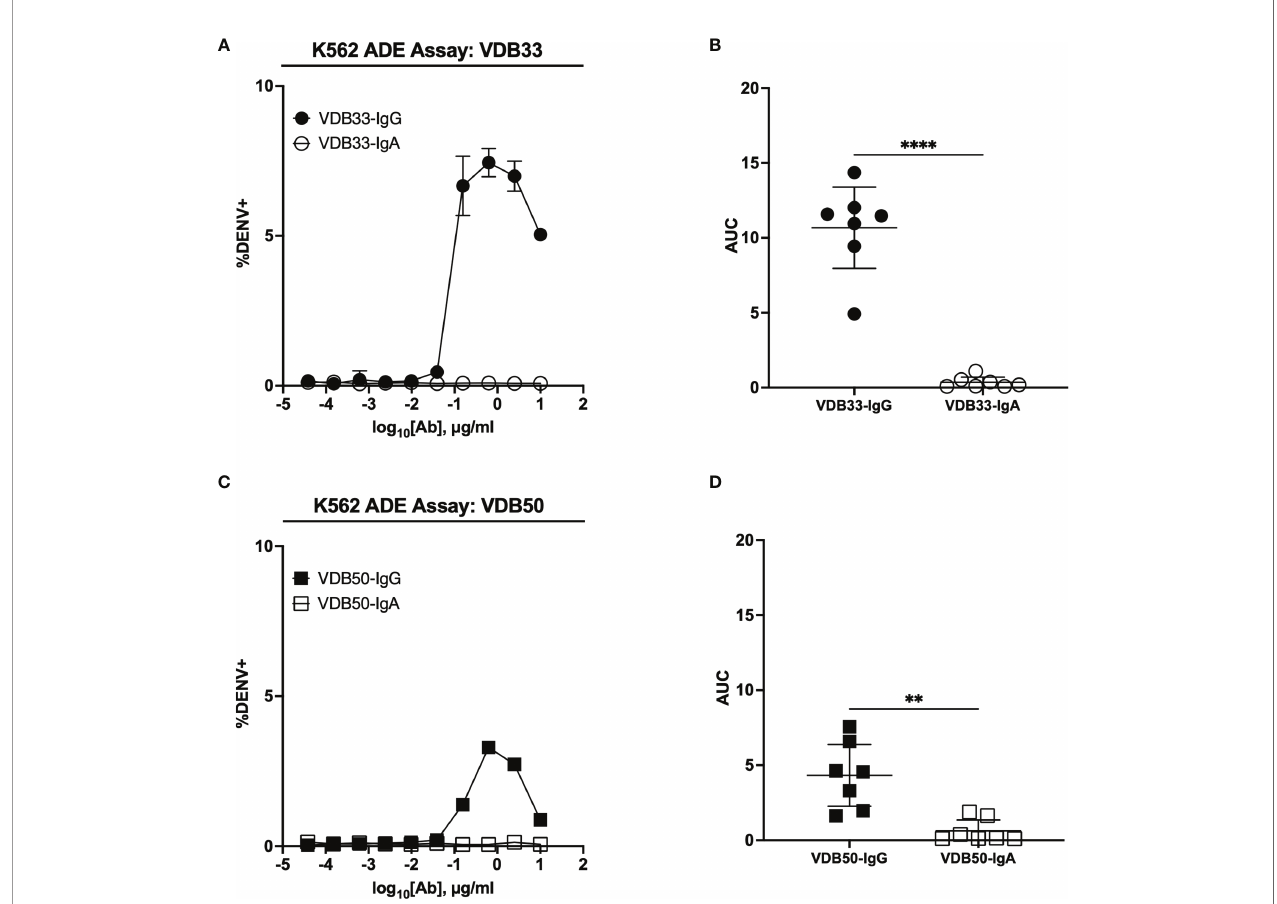
FIGURE 2 | ADE activity of DENV-reactive IgG and IgA isotype antibodies. (A) ADE activity of VDB33-IgG and VDB33-IgA against DENV-3 in K562 cells. (B) AUC values of 7 independent experimental replicates of DENV-3 ADE assay with VDB33-IgG and VDB33-IgA (C) ADE activity of VDB50-IgG and VDB50-IgA against DENV-3 in K562 cells. (D) AUC values of 7 independent replicates of DENV-3 ADE assay with VDB50-IgG and VDB50-IgA. Error bars +/- SEM. **p < 0.01, ****p < 0.0001, unpaired t test. Data are representative of at least 7 independent